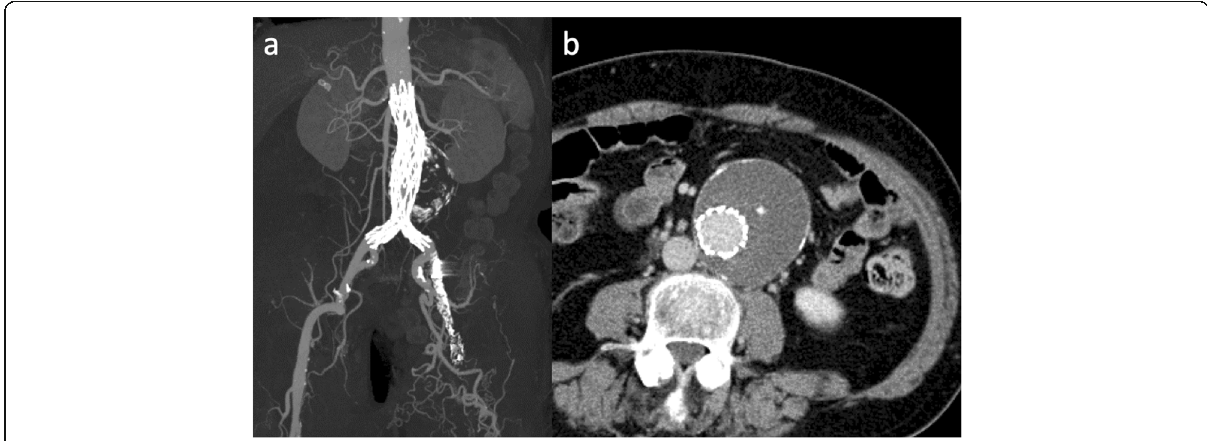
Fig. 3 Post operative CT. a : MIP image of CT angiography shows an implanted stentgraft in the aorta with the bilateral legs deployed in the CIA, b : AAA was successfully sealed without any visible endoleak. AAA: abdominal aortic aneurysm, CIA: common iliac artery, MIP: maximum intensity